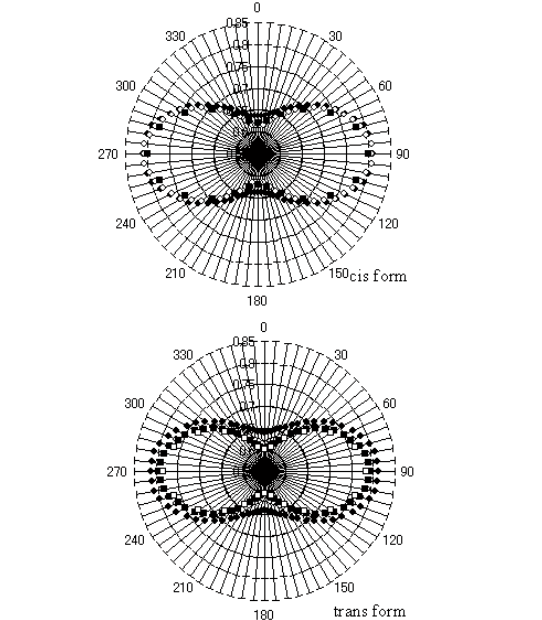
Figure 10. Circular diagram for PMMA-AZ-Mn ϖ  - ϖ * at 320 nm Figure 11. Circular diagram for PMMA-AZ-Mn n  - ϖ * at 436 nm 12 12 for [above] cis form (filled circle for UV after 1 cycle, for [above] cis form and [below] trans form (symbols empty circle for UV after 5 cycles, and filled square for as in Fig. 10). UV after 10 cycles), [below] trans form (filled circle for initial, empty circle for visible after 1 cycle, filled square for visible after 5 cycles, and empty square for visible after 10 cycles).